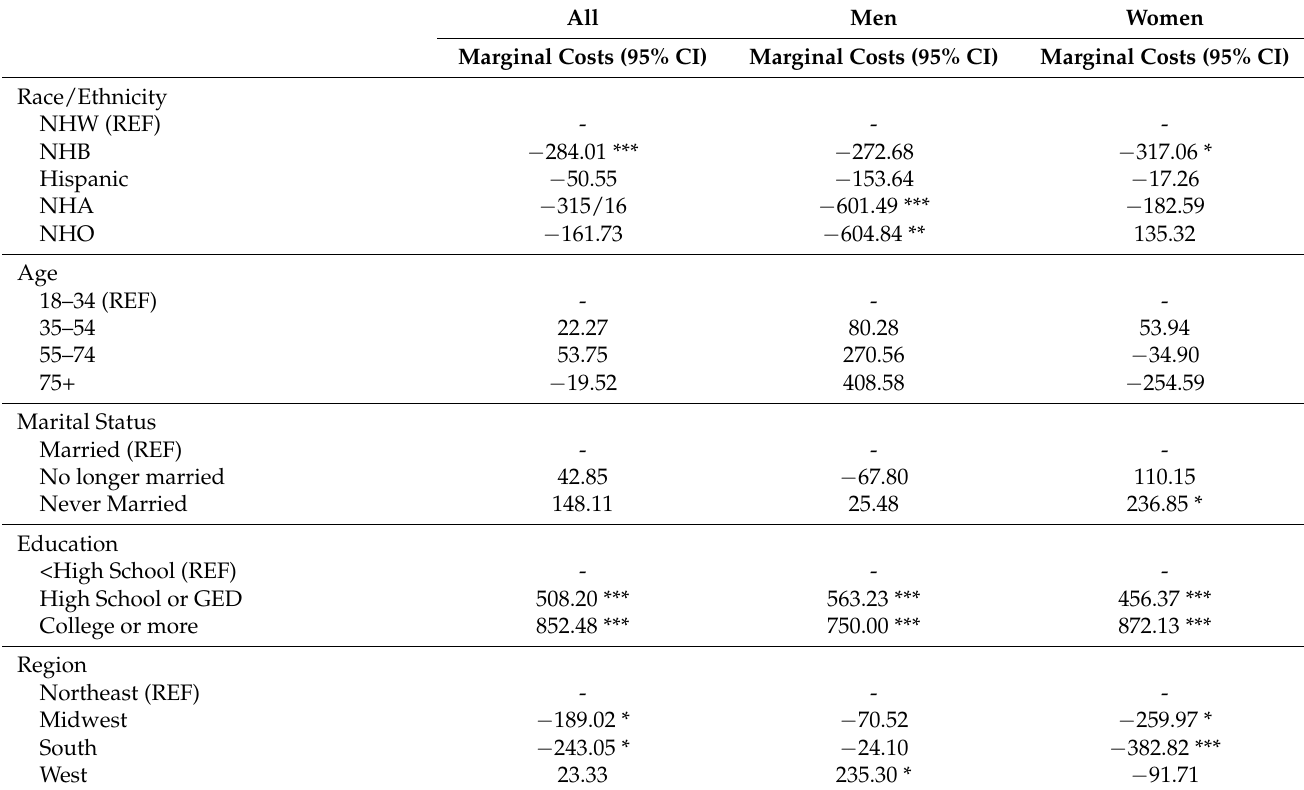
Table 3. Marginal costs from two-part regression model of office-based visit expenditures among men and women with arthritis: United States